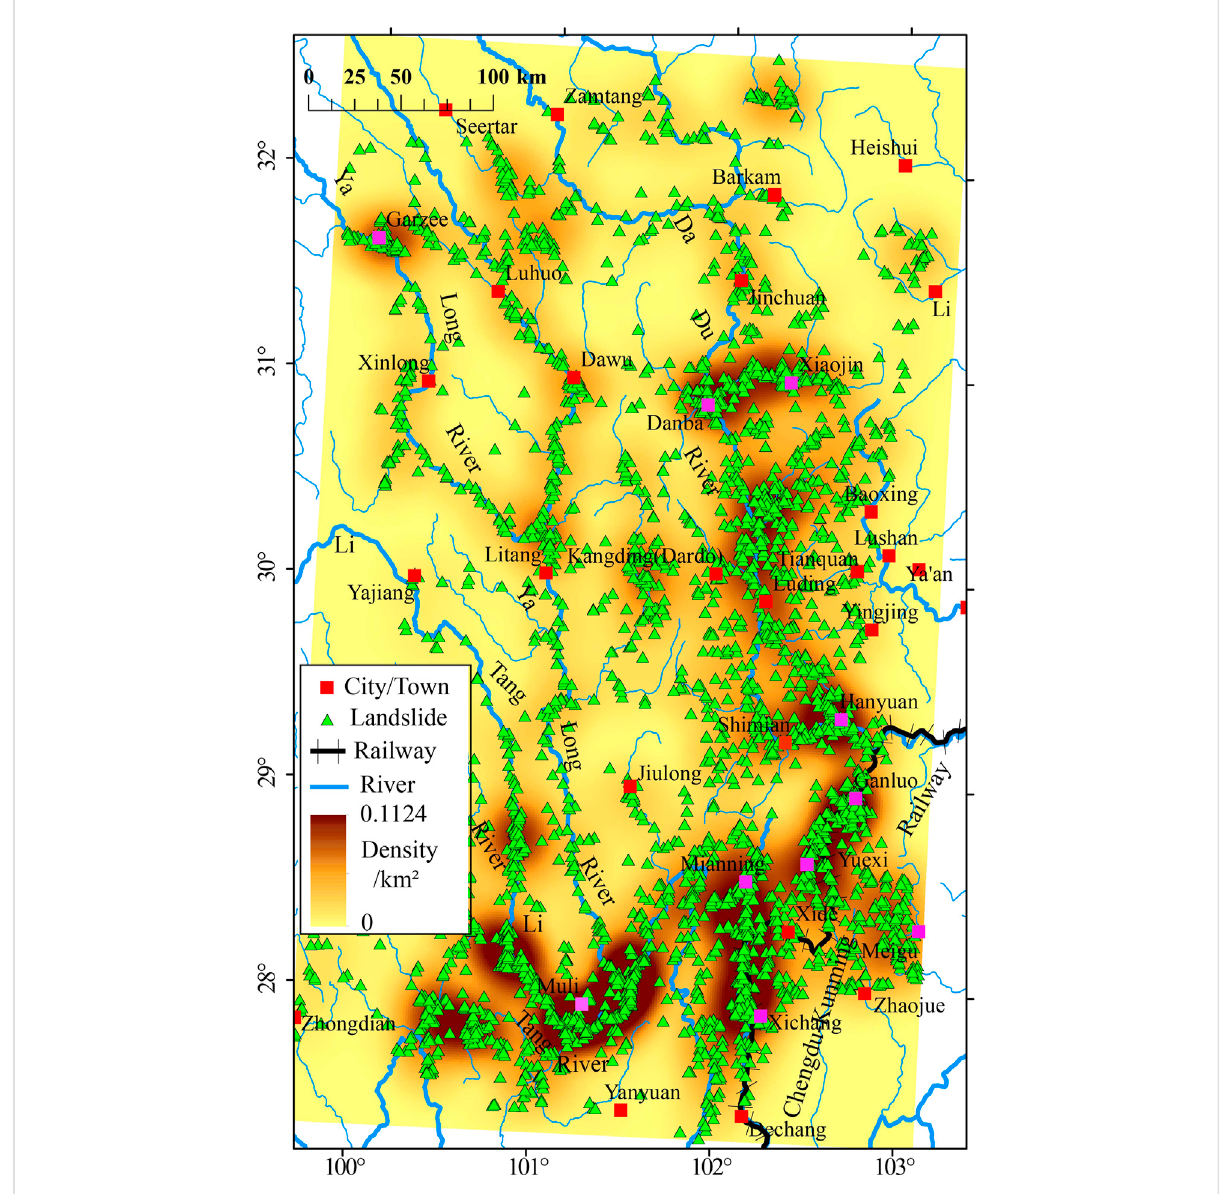
FIGURE 9 A landslide density map based on our detection result with county locations in the studied